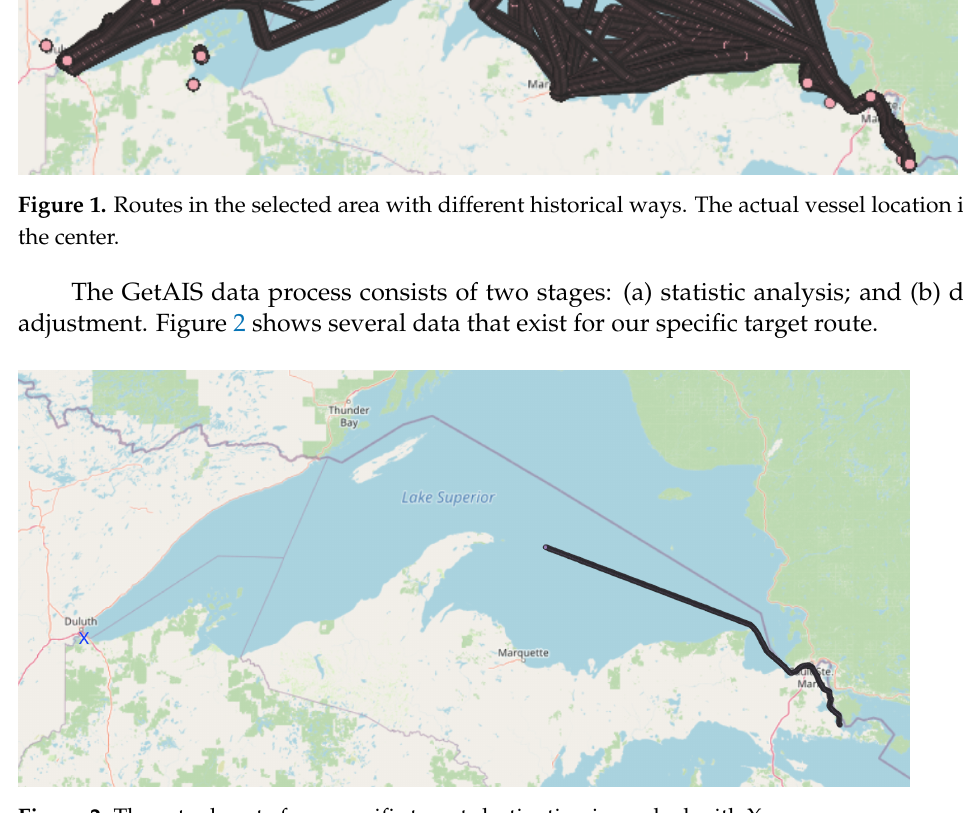
Figure 2. The actual route for a specific target-destination is marked with